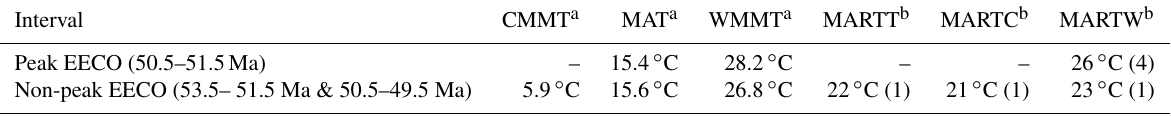
Table 1. Comparison of Eocene MART estimates using different constraining temperatures and calculation methods. Interval CMMT a MAT a WMMT a MARTT b MARTC b MARTW b Peak EECO